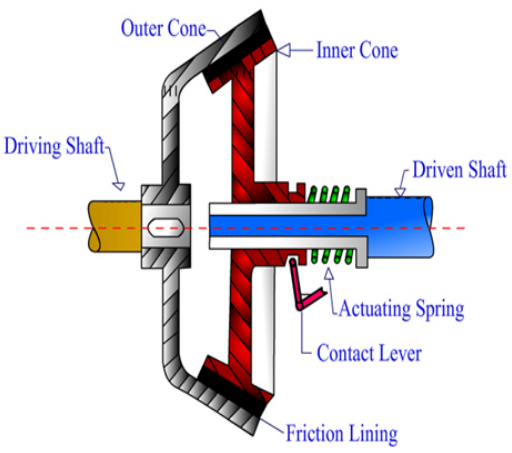
Figure 5. Cone clutch design problem